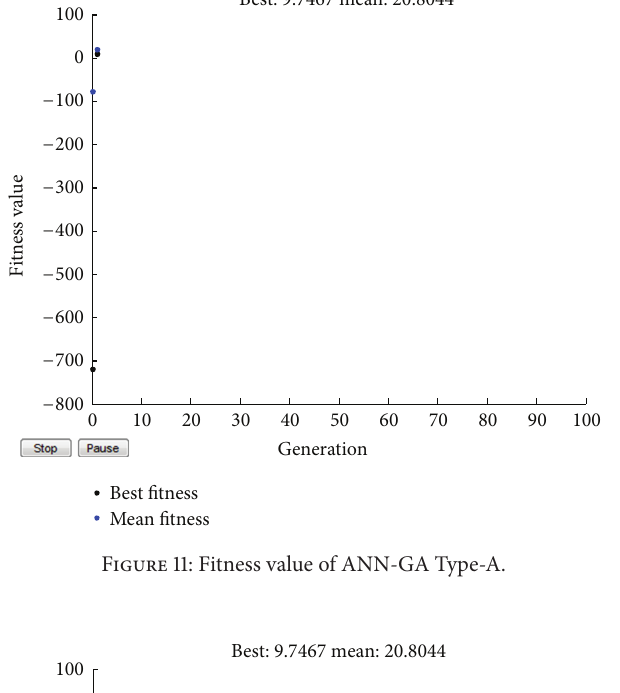
Best: 9.7467 mean: 20.8044